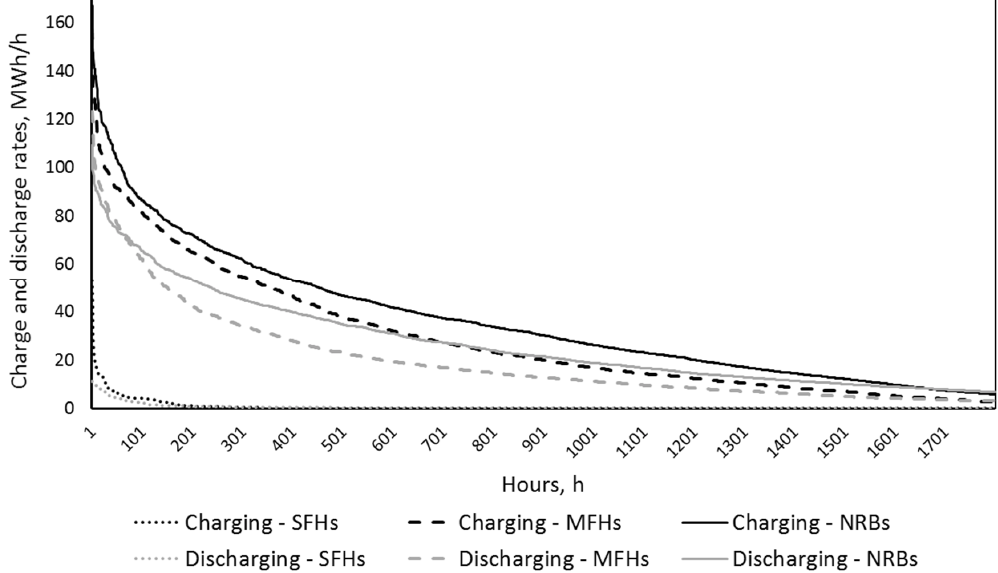
Figure 5. Duration curves for the hourly charging and discharging rates obtained from the modeling of the SFDs, MFDs, and NRBs connected to the DH system of the City of Gothenburg, for the Reference and DR 3 ◦ C scenarios. Note that the x-axis only extends to 1800 h (during the remaining hours, the values are low, and thus, are not